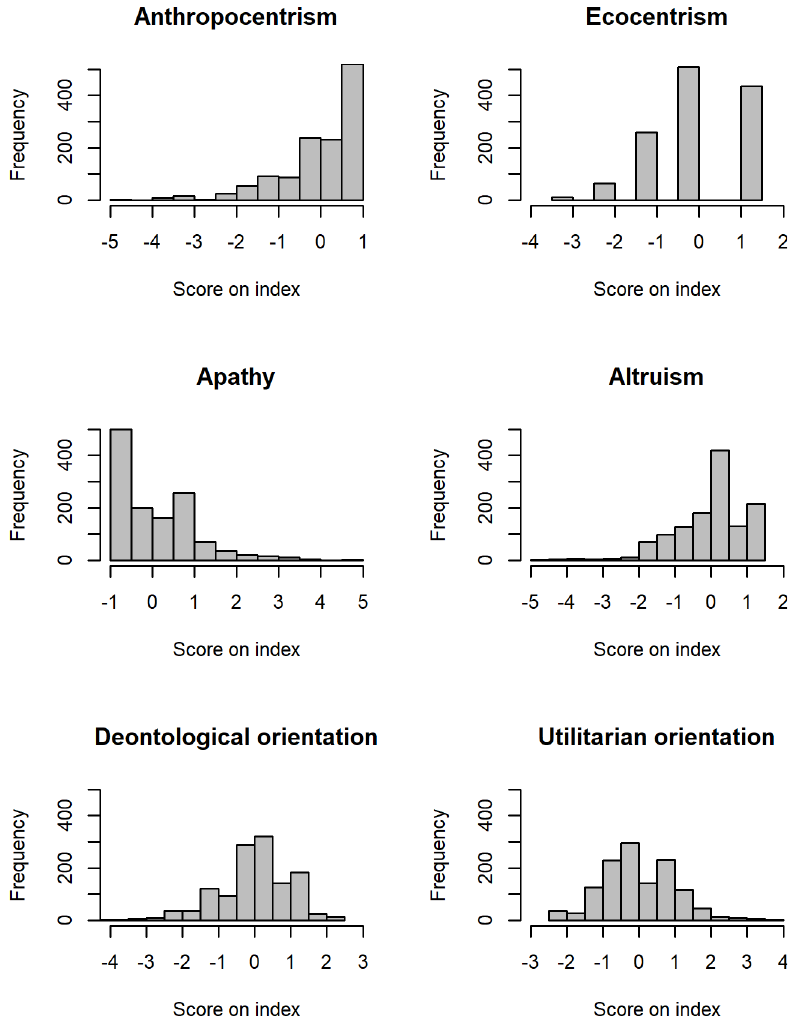
Fig 1. Frequencies of scores on six moral indices (anthropocentrism, ecocentrism, apathy, altruism, deontological and utilitarian orientation). Note: due to a varying number of items of the scales, the index scores possess different ranges; all indices have been scaled (mean = 0, sd = 1) for